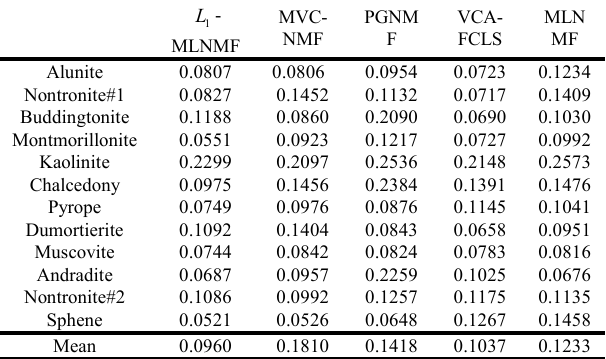
TABLE 1. Comparison results of different methods in terms of